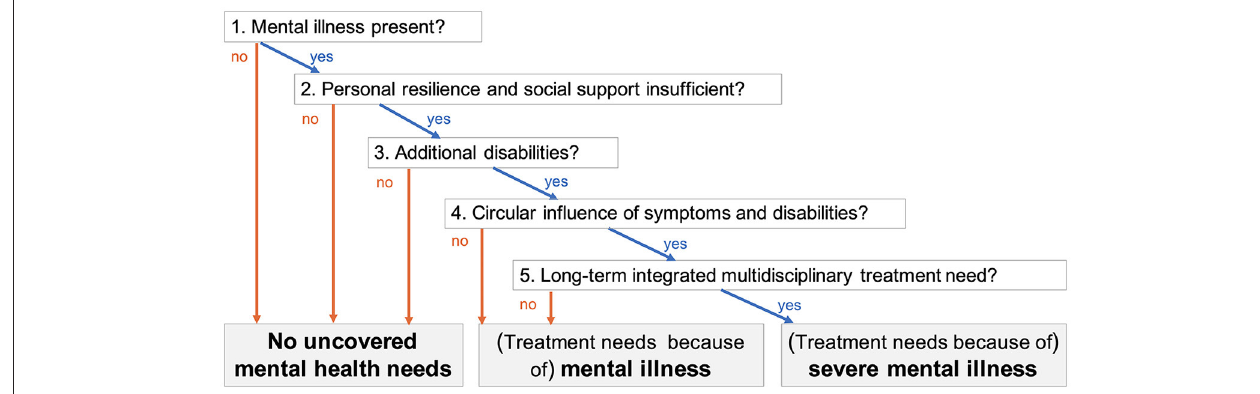
FIGURE 1 | Decision tree to assess Mental Health Related Care Needs.